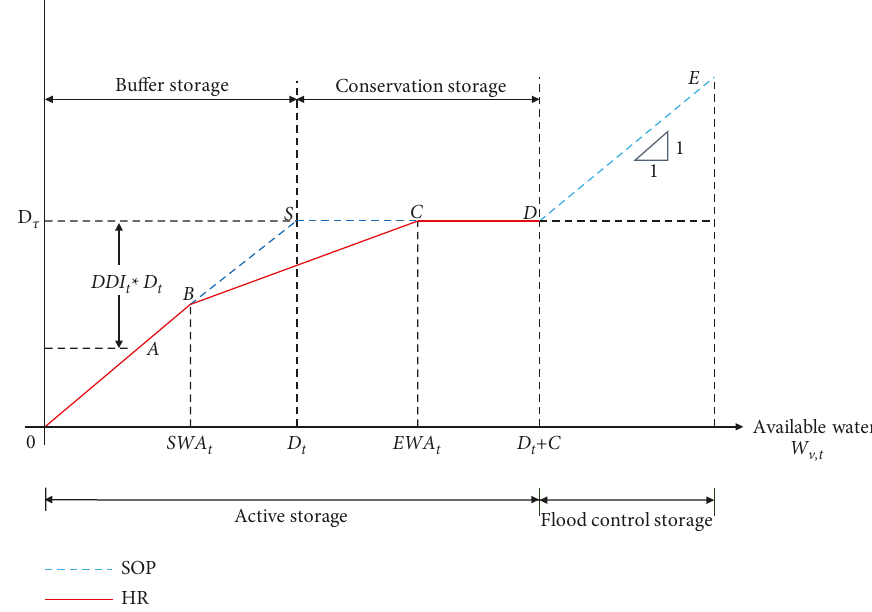
Figure 4: The HR and standard operating policy.